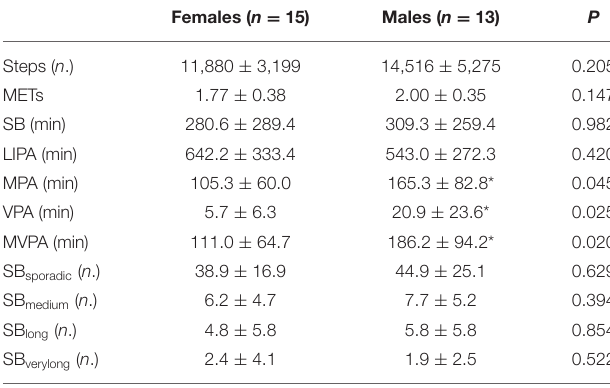
TABLE 1 | Physical activity and sedentary behavior before